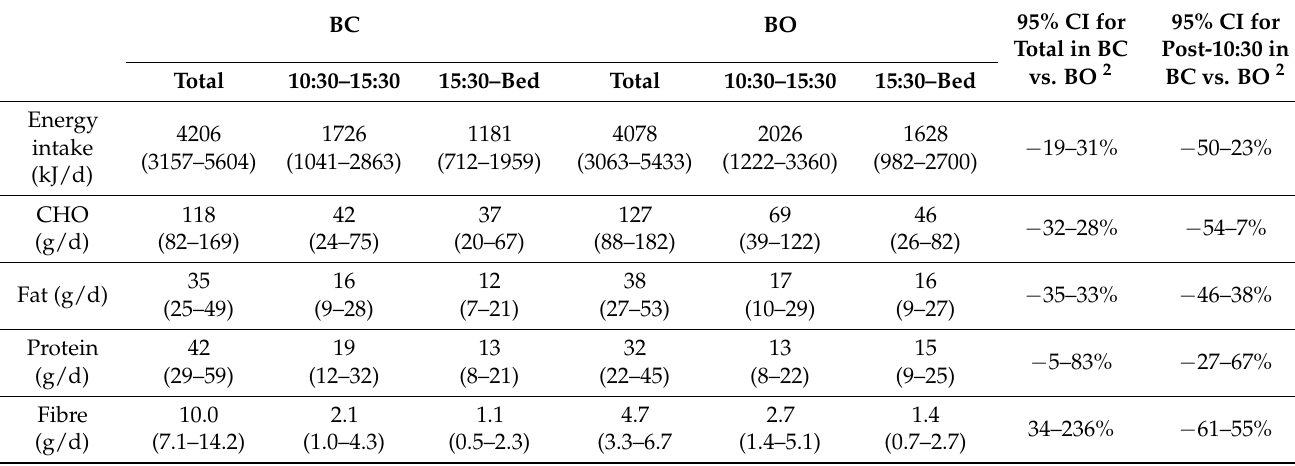
Table 4. Dietary intakes of adolescent girls who participated in randomised crossover trial comparing seven days of breakfast consumption (BC) with seven days of breakfast omission (BO) 1 .